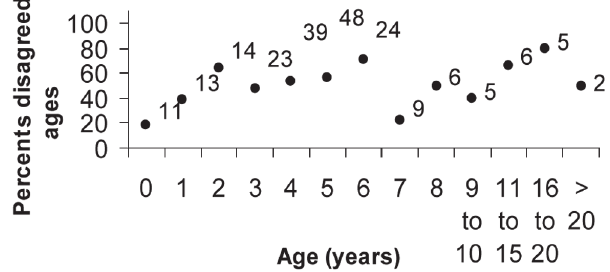
Fig. 4. Observed percentages of samples for which the first and second readings disagreed of the dog snapper Lutjanus jocu from Abrolhos Bank. Age is the first reading (number of rings). The numbers represent the sample size. Older ages were pooled due to the small sample size.